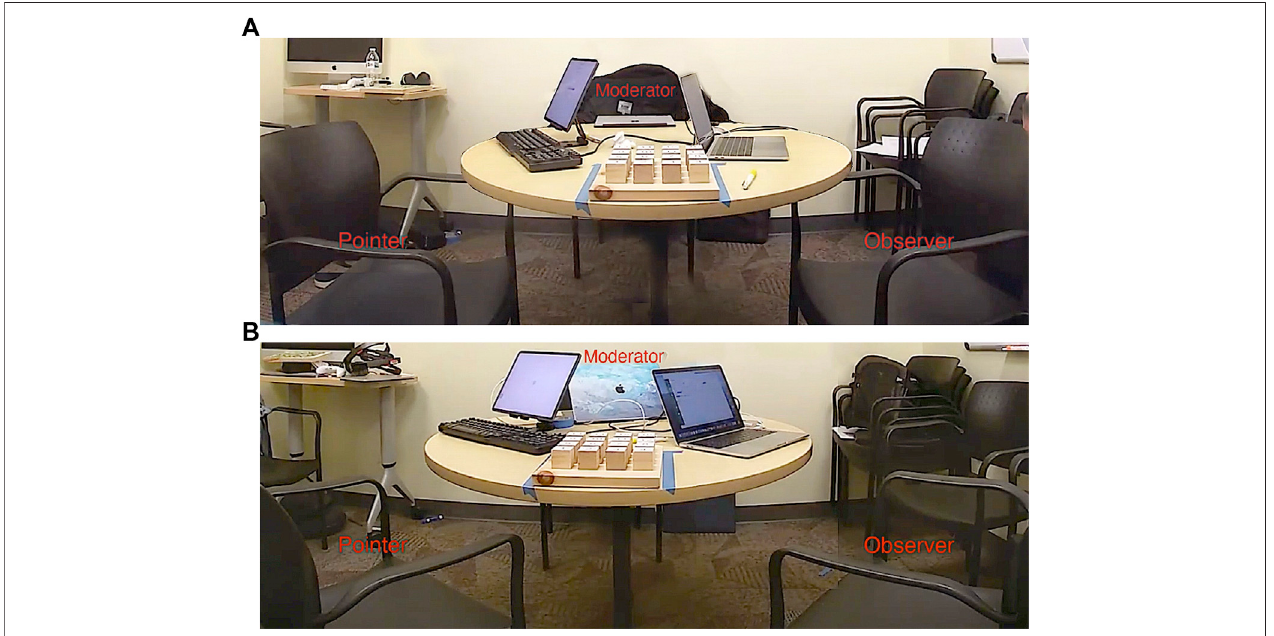
FIGURE3| Experimentsetup:Thechairswerealignedwithtapeonthegroundtoform180 ° and90 ° con fi gurations forthephysical, face-to-face condition (A) and the physical, side-by-side condition (B) , respectively. The target cubes were placed at fi xed locations on the table. The laptop and monitor were adjusted by the participants for ease of use. The image was taken with a GoPro fi sheye